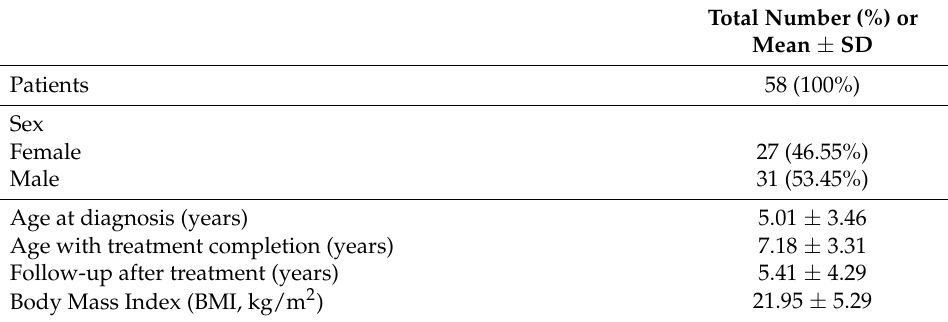
Table 1. Baseline characteristics of the study